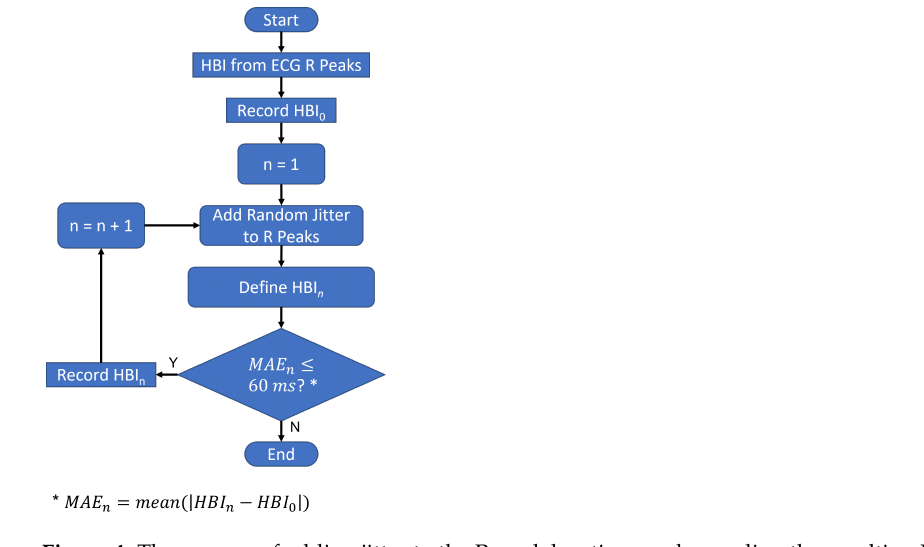
Figure 4. The process of adding jitter to the R-peak locations and recording the resulting